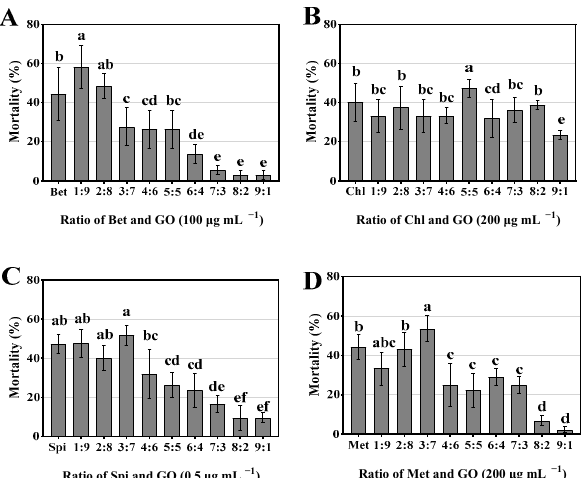
Figure 6. Mortality of S. frugiperda upon treatments with different pesticides or with different mass ratios in combination with GO. Mortality rates of Spi and GO ( A ), Chl and GO ( B ), Bet and GO ( C ), Met and GO ( D ) under different mass ratios. Data are mean ± standard error (SE). Error bars represent the SE (N = 3). Different lowercase letters indicate significant differences among treatments (Fisher’s protected LSD test, p < 0.05).